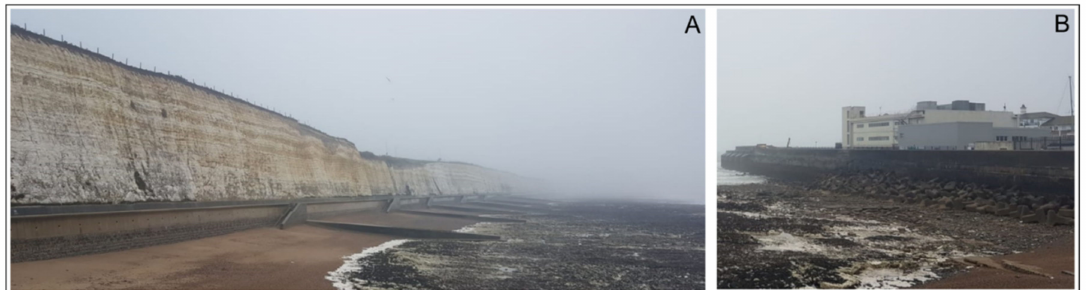
Figure 6. Roedean site at low tide. Photograph ( A ) showing the view looking east, visible groynes in the distance and sediment accumulating in between, with a chalk platform in front of the sediment. Photograph ( B ) looking southwest, showing the end of the Marina and a rip-rap shore protection in front.